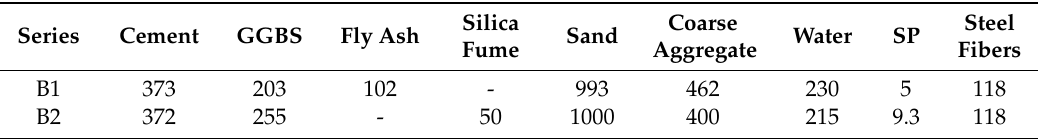
Table 3. Details of mix proportions (kg / m 3